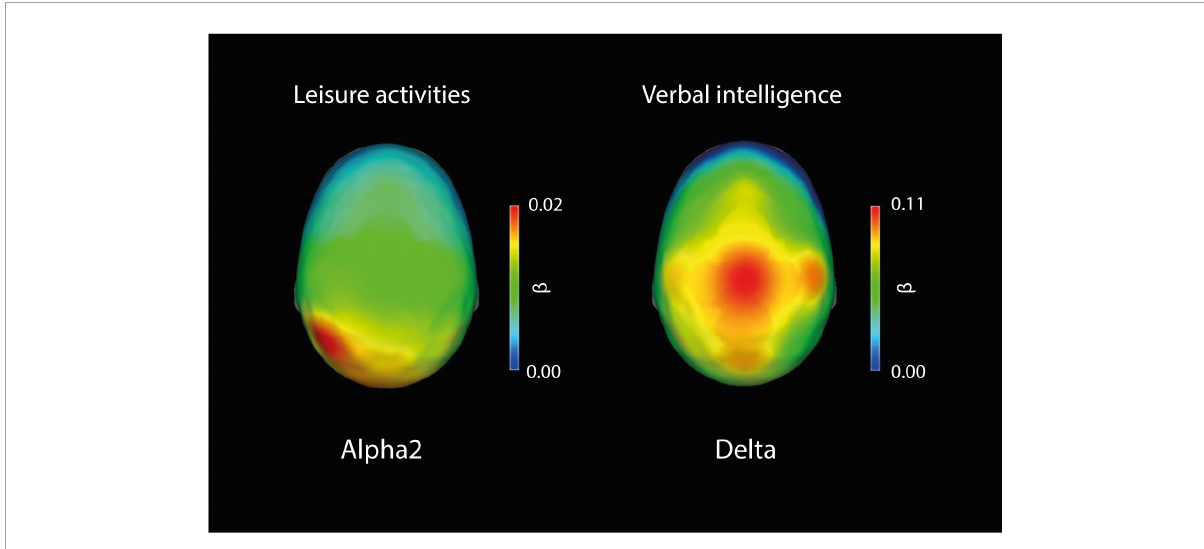
FIGURE2 Topographic representation of the scalp distribution of beta values for each electrode of the frequency bands with its statistically significant (Bonferroni corrected: p < 0.008) predictors. Leisure activities as a predictor of Alpha2: All electrodes were significant. Verbal intelligence as a predictor of delta: C3, C4, P3, P4, O2, Fz, Cz, and Pz were